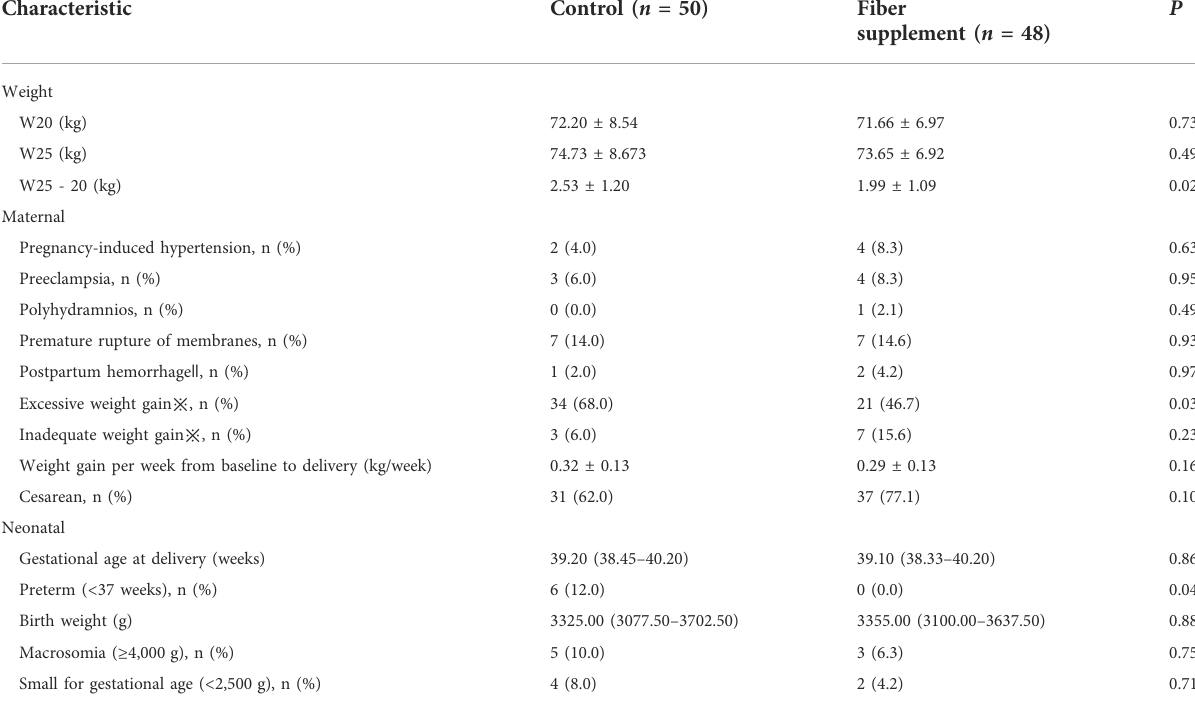
TABLE 5 Weight control and Outcomes of pregnancy complications, delivery events, and neonatal in fi ber supplement and control groups.